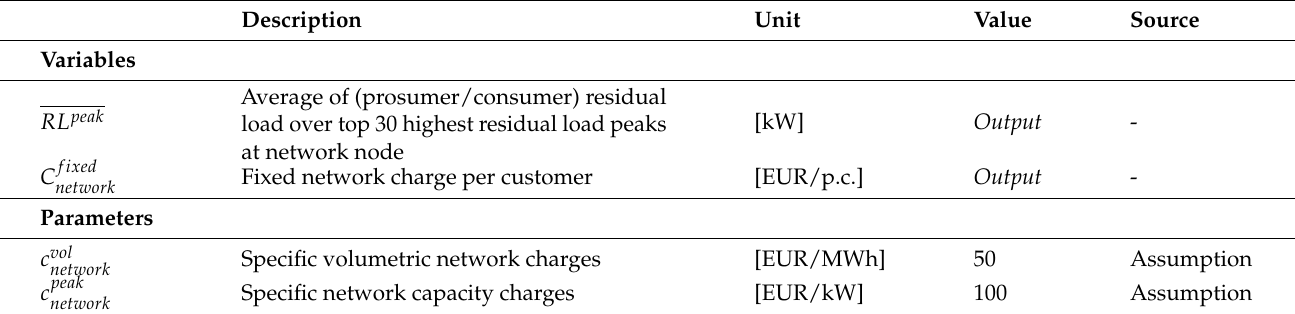
Table 2. Summary of used variables and parameters for network charge